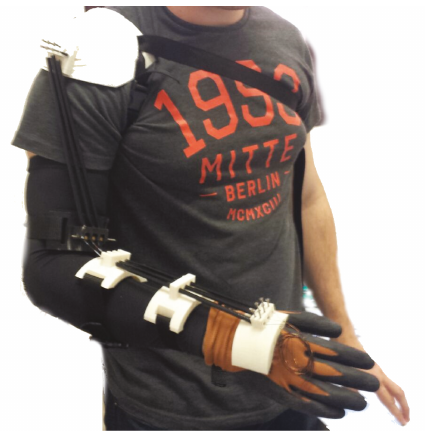
Figure 8: Wearable exoskeleton for elbow medical rehabilitation with shape memory alloy